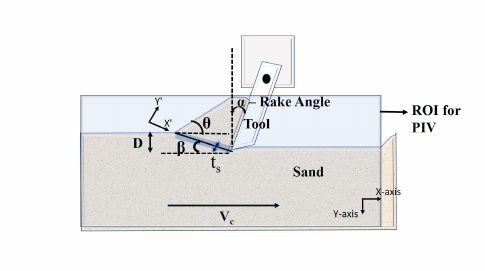
Figure 1. Schematic of the experimental set-up with D being the initial depth of cut and V c , the cutting speed